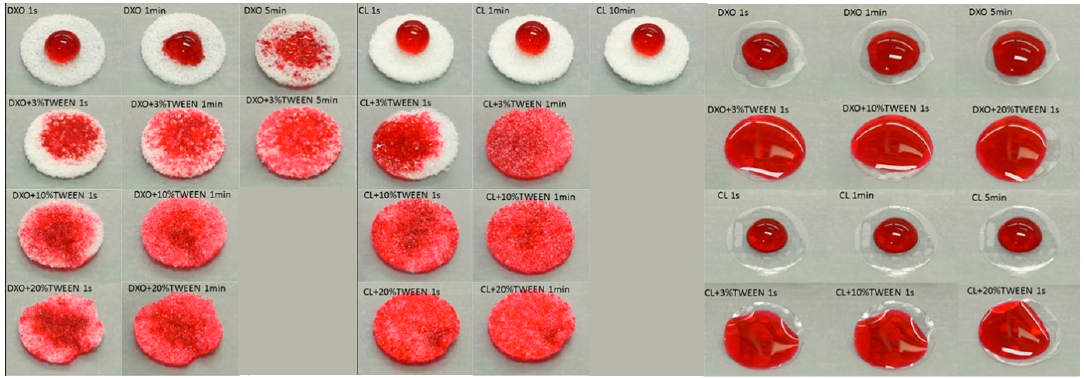
Figure 2. The spreading of Ponceau S Red solution on the films (the right) and the penetration of Ponceau S red solution into different scaffolds (the left).The dye solution could not totally spread on the films of the DXO and CL groups, but it could quickly diffuse on the films that contained Tween 80. Meanwhile, DXO showed a better spreading than CL.